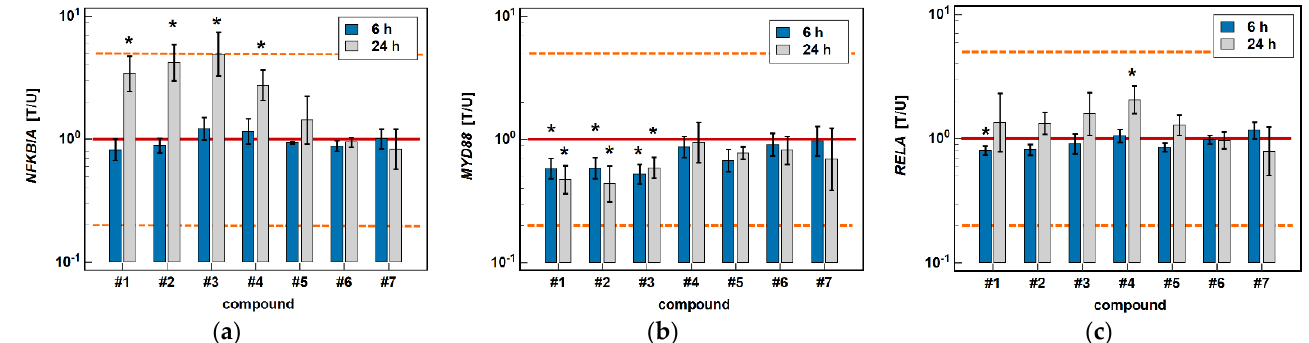
Figure 13. Effect of oxicams on the expression of NFκB -associated genes in Caco-2 cells: ( a ) NFKB1A ; ( b ) MYD88 ; ( c ) RELA . The bars and whiskers represent the mean ± SD expression ratio of the normalized relative quantities [NRQ] obtained for cells treated with 200 µ M oxicams for 6 and 24 h, and the corresponding untreated controls [T/U]. The significant differences between the treated and untreated cells, analyzed using a t -test for paired samples, are indicated by asterisks (*). An expression ratio of 1 (no change) is indicated by a red solid reference line, while an expression ratio of 5 (5-fold upregulation) and an expression ratio of 0.2 (5-fold downregulation) are indicated by an orange dashed reference line. Compound # 6 denotes piroxicam, and # 7 denotes meloxicam.